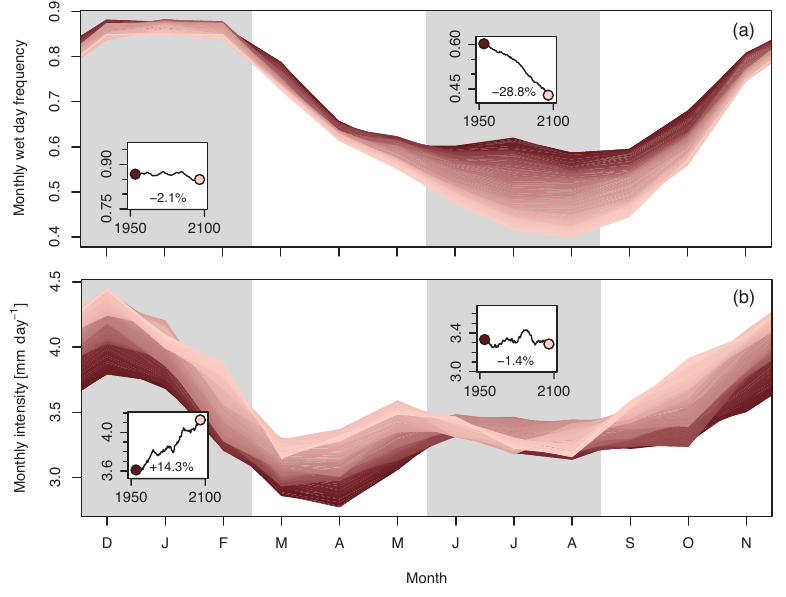
Fig. 5. Projected evolution of the seasonal cycle in wet-day frequency (a) and in intensity (b) from the beginning (dark shading) to the end (light shading) of the ESSENCE period, for the North Rhine region. Monthly values were averaged over a sliding window of 21 years. Insets show the ensemble mean temporal evolution for DJF and JJA.